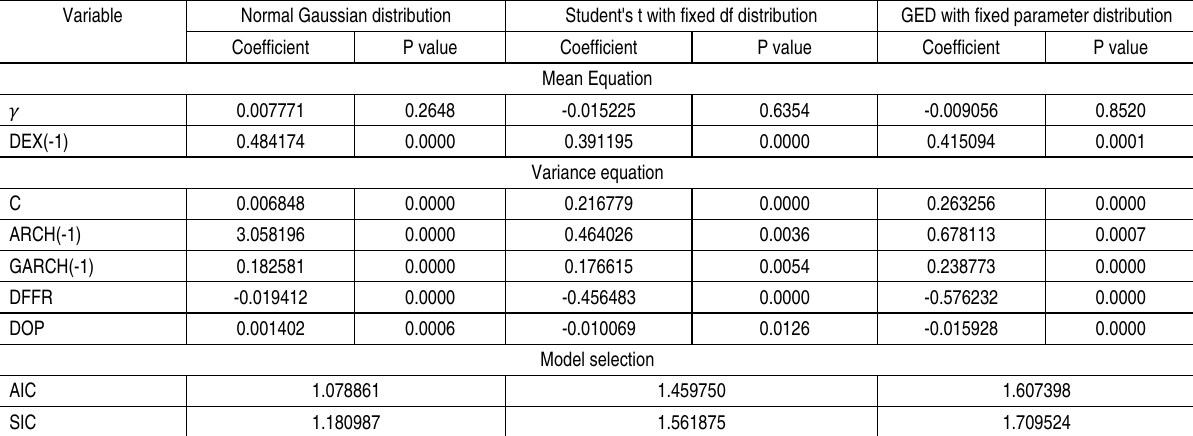
Table 2. Result of GARCH (1,1) model